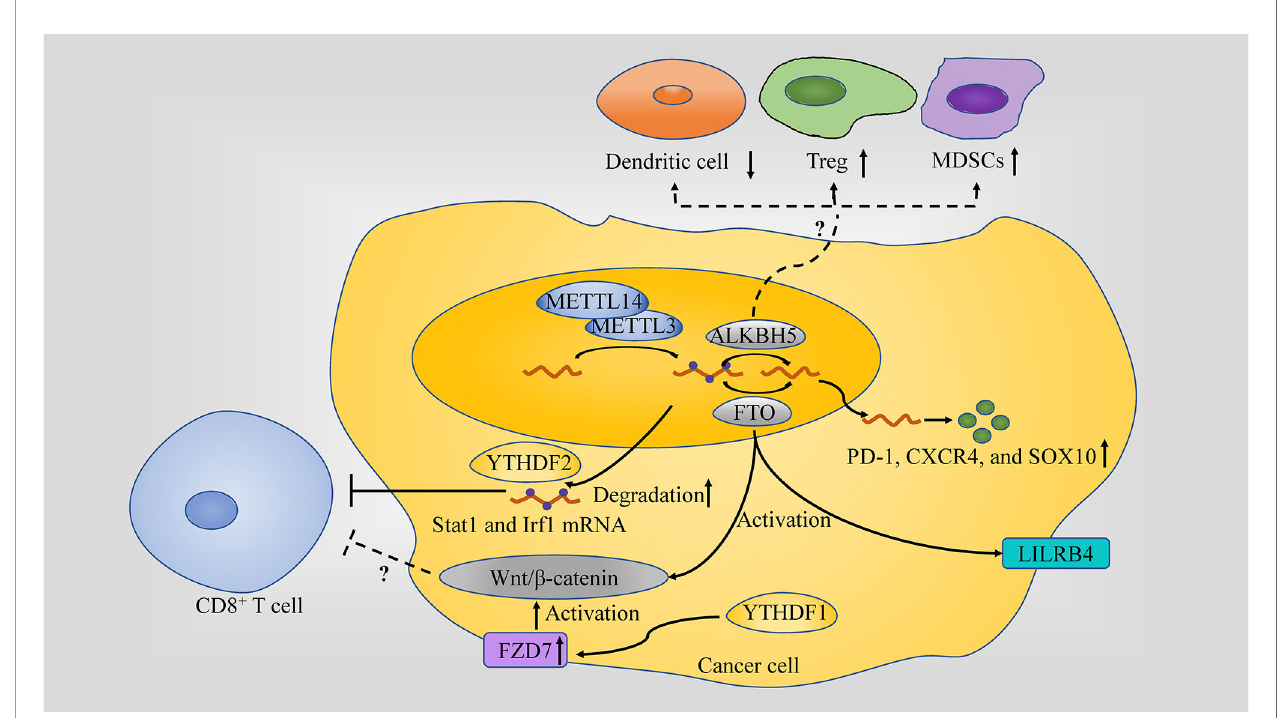
FIGURE 2 | Role of m6A in the anti-tumor immune response. m 6 A regulators play different role in anti-tumor immune response: (1) METTL3 or METTL14 inhibit IFN- g -Stat1-Irf1 signaling through decaying the Stat1 and Irf1 mRNA via Ythdf2. (2) FTO directly upregulate leukocyte Ig-like receptor B4 (LILRB4) which is an immune checkpoint gene expression via an m6A-dependent mechanism in AML; Through targeting PD-1, CXCR4, and SOX10FTO in cancer cell, FTO causes the resistance to the killing activity. (3) ALKBH5 affects the tumor in fi ltration of Tregs, MDSCs and DCs in TME. (4) Wnt/ b -catenin hyperactivation through FZD7 overexpression which is mediated by YTHDF1 or by FTO is associated with non-T cell in fl amed TME (a lack of CD8+ T cells along with